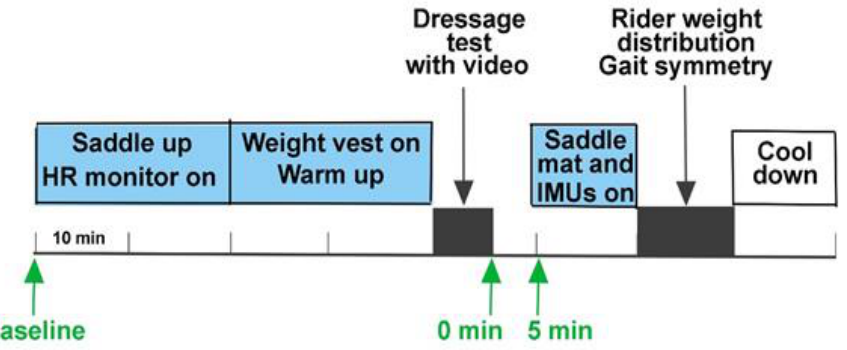
Figure 1. Daily procedure on test days 2–4. The heart rate monitor was attached during saddling. Three saliva samples were collected: prior to saddling (baseline); immediately after the dressage test (0 min); and 5 min after the dressage test (5 min). After taking the 5 min saliva sample, the electronic saddle pressure mat was attached. Rider weight distribution was measured by the pressure mat while riding two 20 m circles to each of the left and right sides in sitting trot.